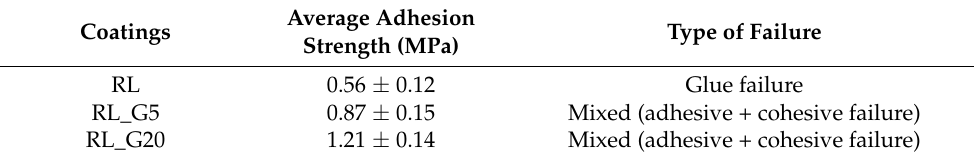
Table 4. Coatings’ pull-off strength with the evaluation of the type of failure.